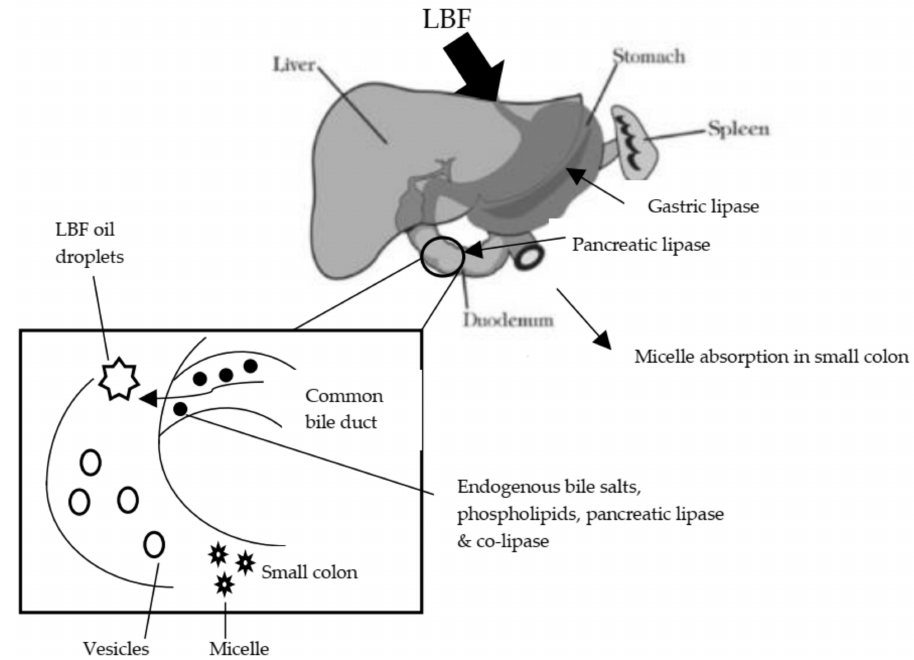
Figure 3. Diagram of drug delivery system for oral lipid-based formulation (LBF) drug and its absorption. LBF drug enters the stomach where gastric lipase hydrolysed and stabilised the drug in the stomach, due to the presence of its excipient and surfactant. An excipient is defined as the drug carrier, usually lipids that help to solubilise drugs. A surfactant is a surface-active agent that solubilises drugs further or emulsifies them. Gastric agitation and emptying transport these hydrolysed lipids into the duodenum, where they are subjected to bile salt and pancreatic lipase digestion. Subsequently, micelles are formed and loaded with an LBF drug. Formed micelles are transported along the small intestine where absorption occurs, and the drug is transported to the targeted organ for drug